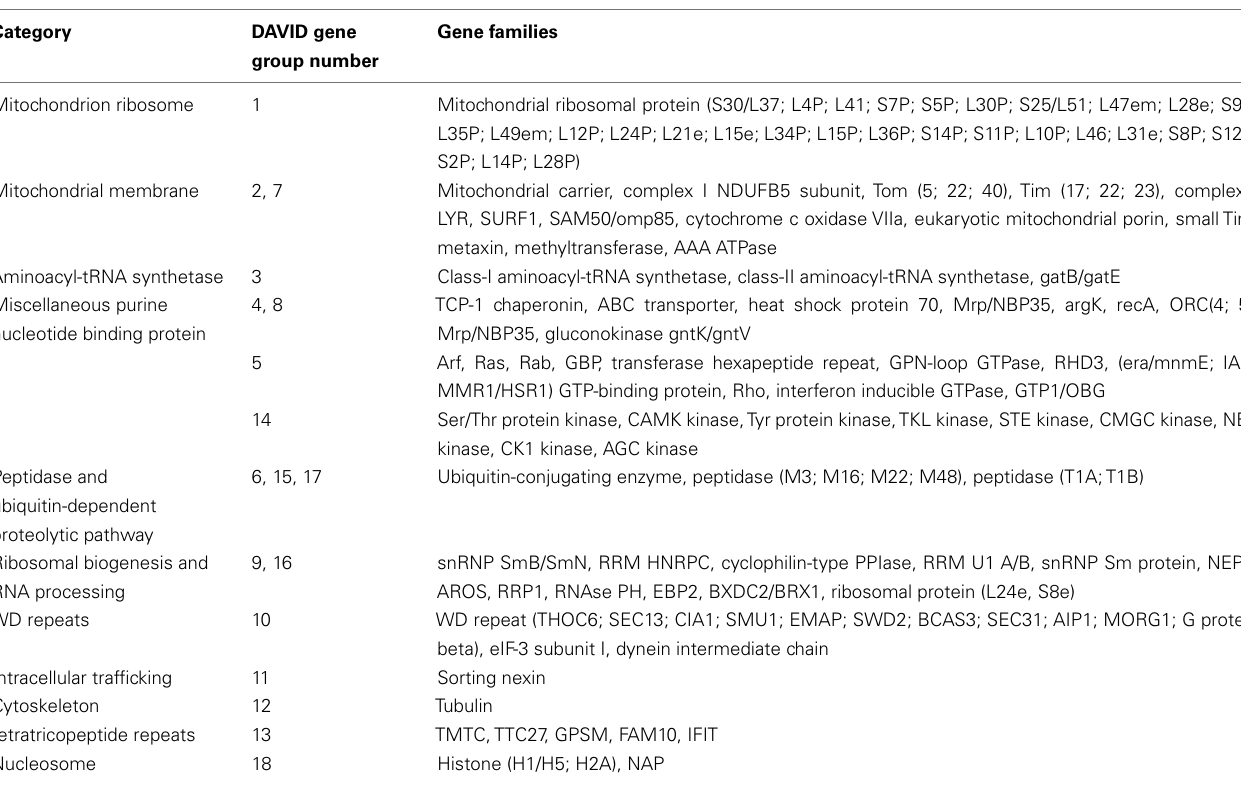
Table 3 | Gene families of up-regulated genes in 14-day hyperglycemic MBL null mice compared toWT control. Category